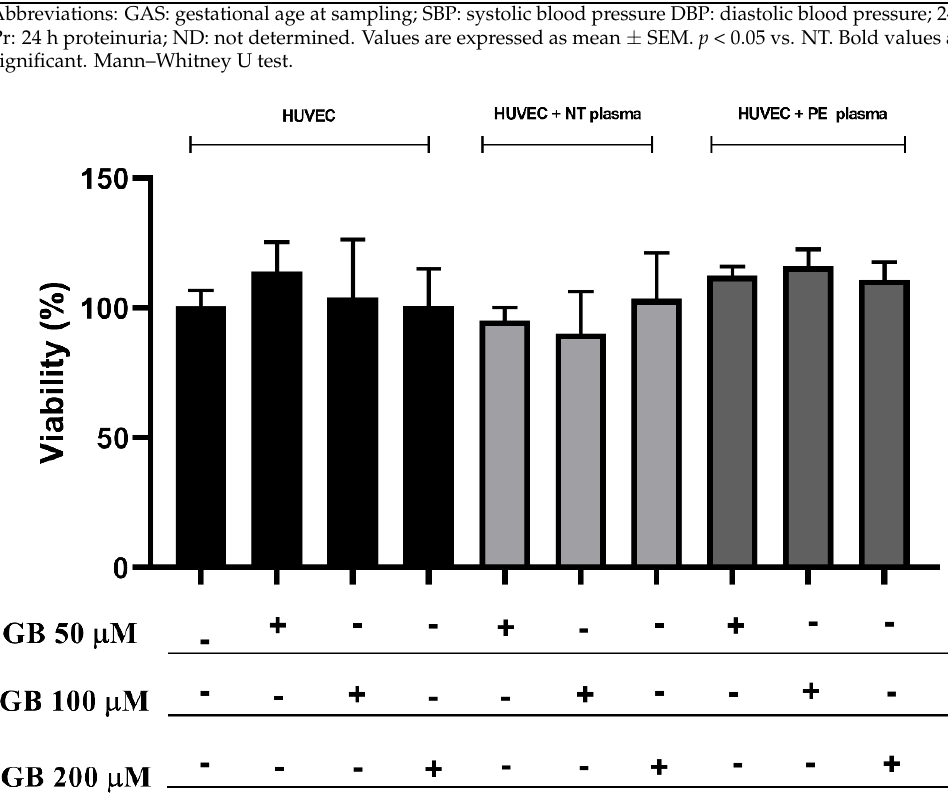
Figure 1. There were no differences in HUVEC viability between treatment with glibenclamide (GB) or the combination of GB (50, 100, and 200 µM) plus plasma of NT (n = 10) and PE (n = 10) pregnant women for 24 h. Three independent experiments with replicates of 5 per group in each experiment. Data are presented as mean ± SD